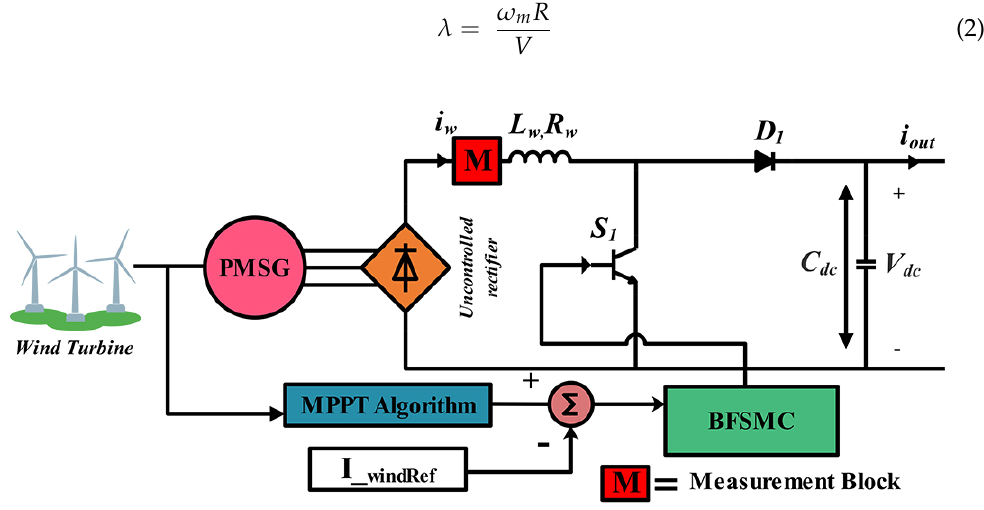
Figure 2. Wind energy system